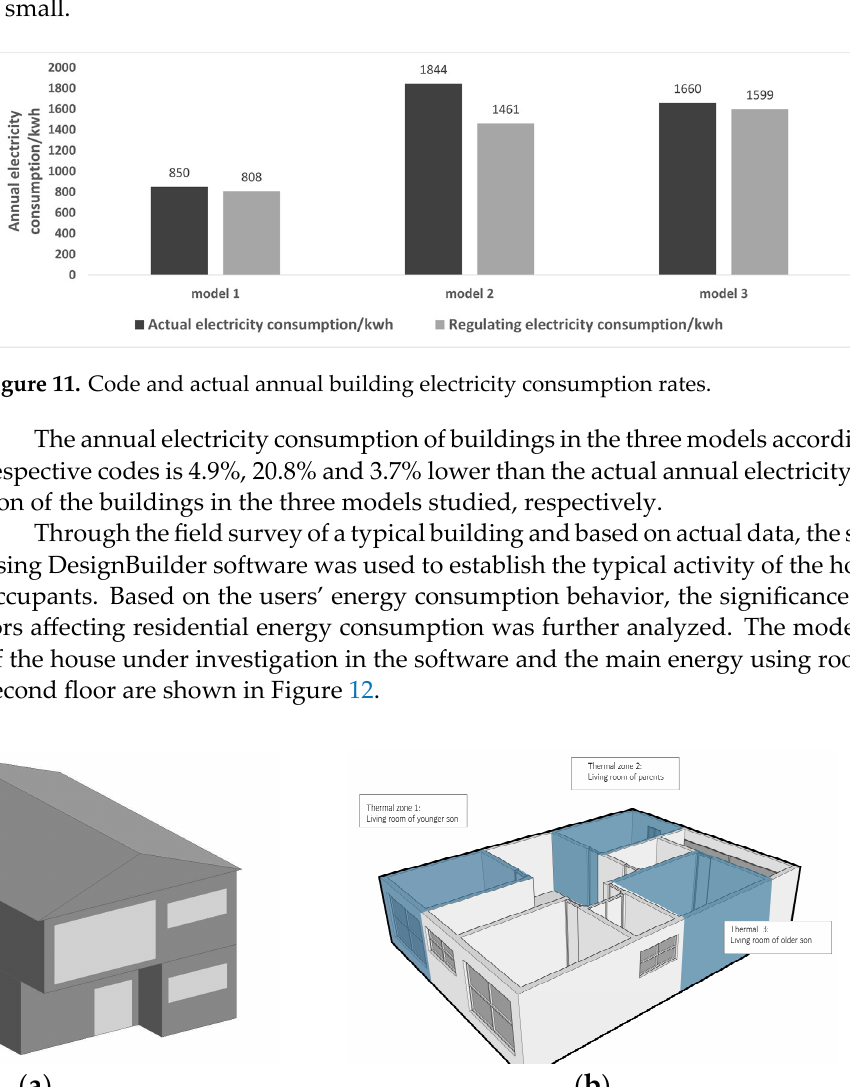
Figure 12 . ( a ) Aerial view of the residence in DesignBuilder; ( b ) the main energy using room on the 2nd floor of the residence.